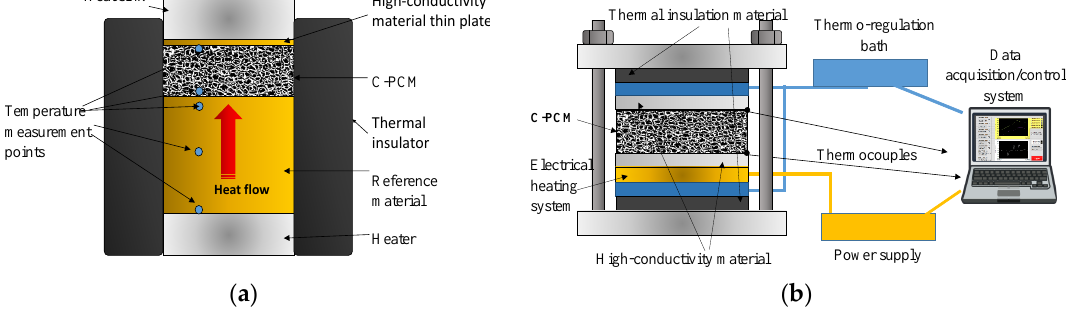
Figure 3. Axial flow methods: ( a ) A scheme of a comparative cut bar, ( b ) an example of the symmetric experimental setup (adapted after [11] with permission from Elsevier).